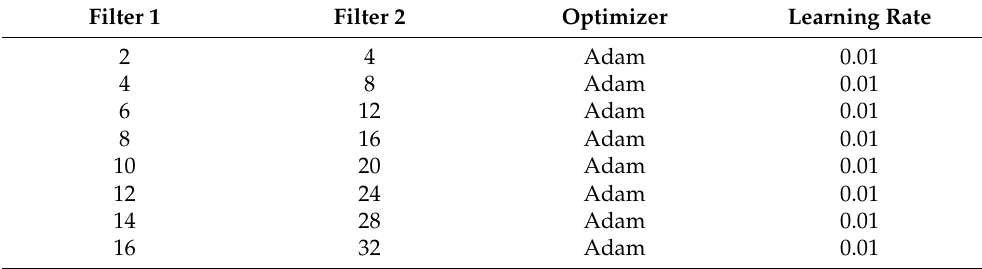
Table 1. ResNet-18 model filter configuration and training parameters used for the patch-level and image-level